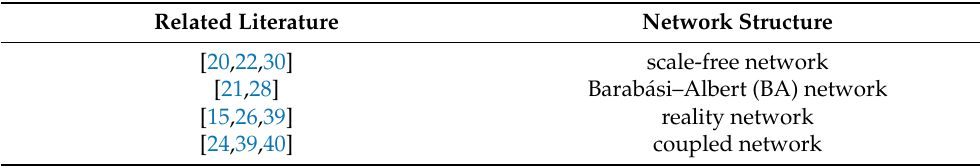
Table 1. Some planar structural networks for cascading failure